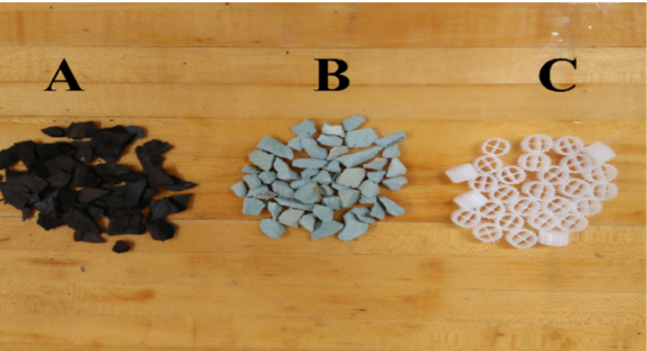
Figure 2. The three different biofiltration media used in this study: ( A ) biochar, ( B ) zeolite, and ( C )